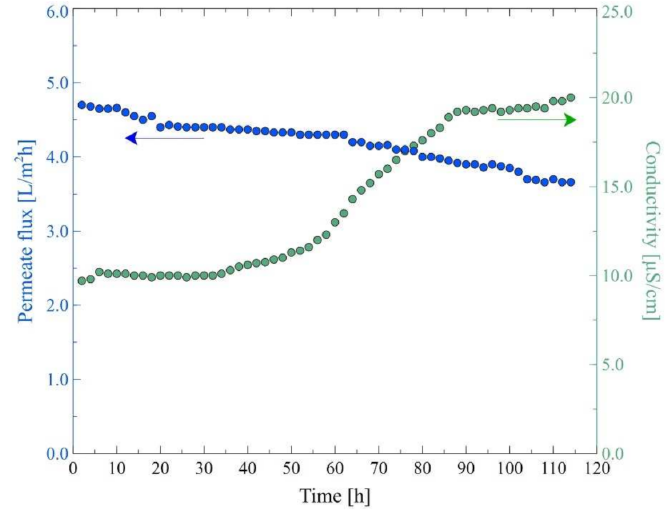
Figure 18. Changes in the permeate flux and distillate conductivity. Feed: oily wastewater OWW1, T F = 333 K, v F = 0.12 m/s. Module M5.